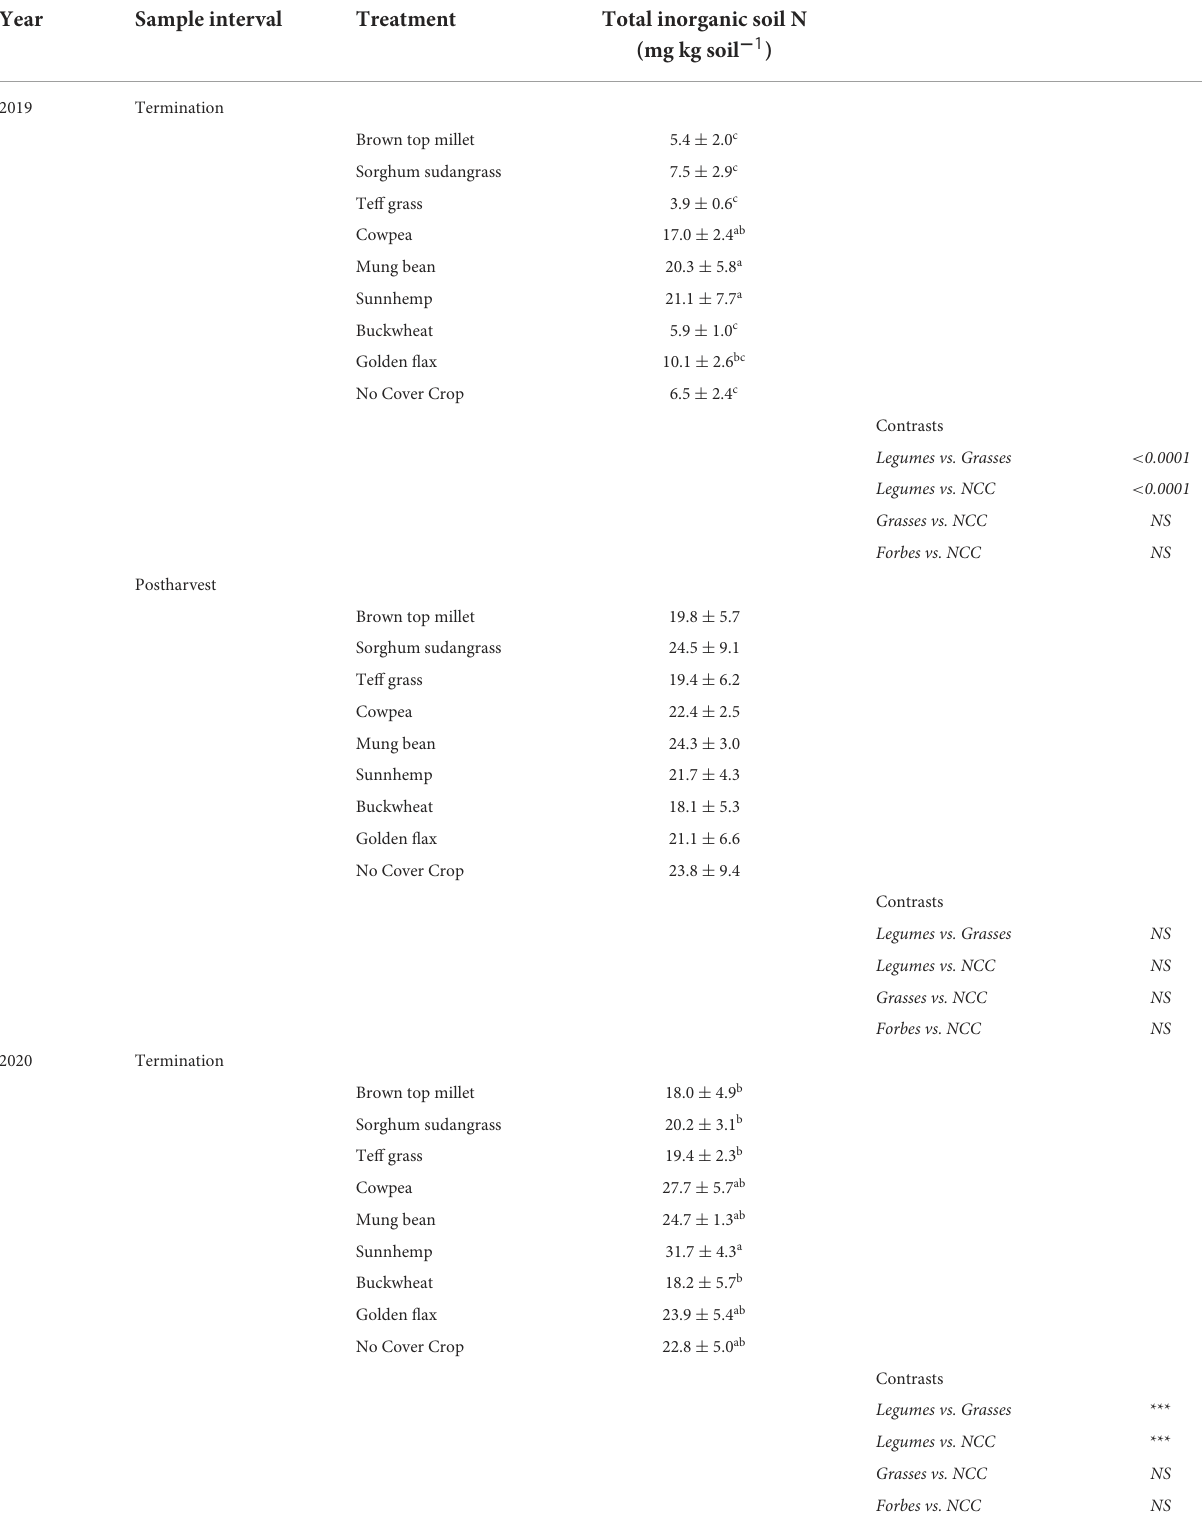
TABLE 7 Mean total inorganic soil N sampled at cover crop termination and post vegetable harvest in Ames,